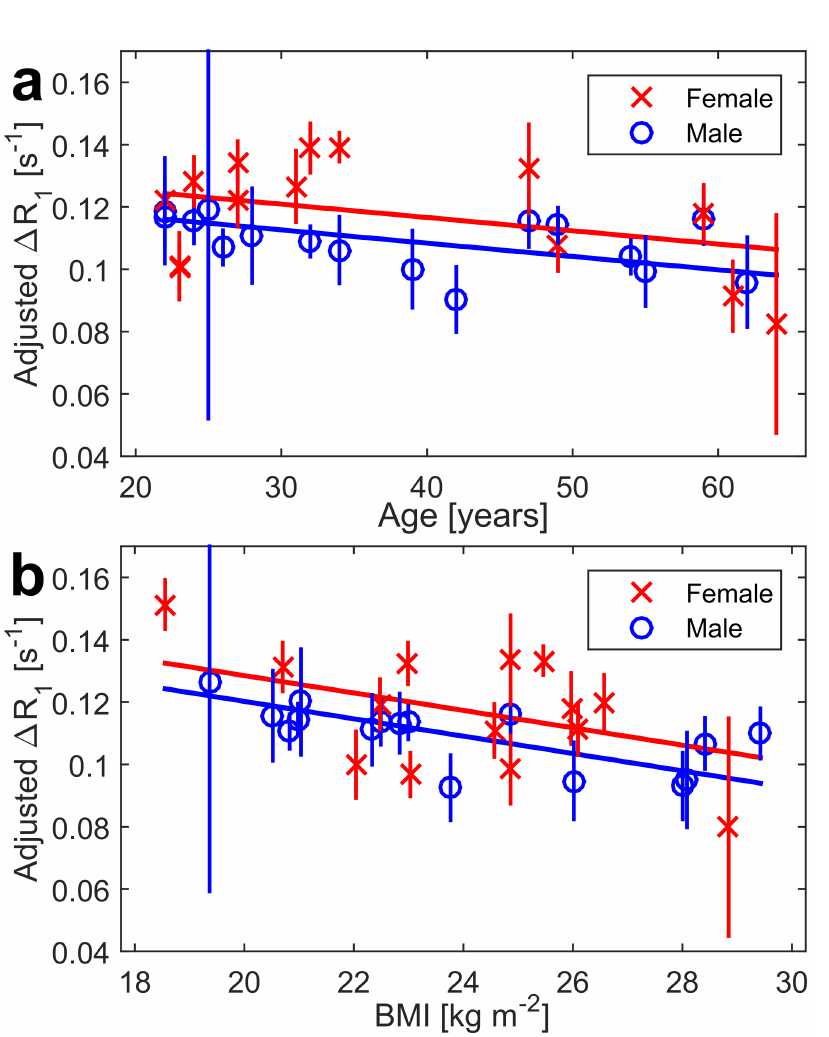
Fig 2. Main result plots of OE as a function of age and BMI. Equation: Δ R 1 = Δ R 1 , 0 (sex) + C 1 Age + C 2 BMI + C 3 Age x BMI + C 4 Δ V L , wholemodel R 2 is 0.66 at p = 5e-5 for n = 30 participants. Error bars represent the coefficient of variationin repeatedmeasurements of R 1 a) Δ R 1 adjusted for BMI and Δ V L as function of age and sex b) Δ R 1 adjusted for age and Δ V L displayedas function of